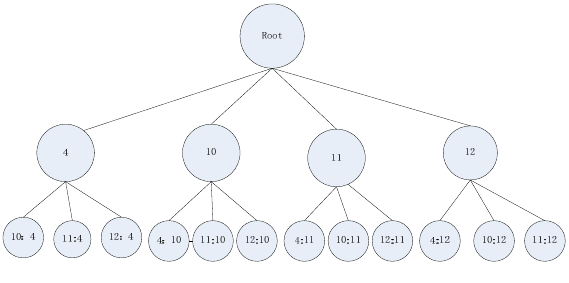
Fig.5. Exponential Tree